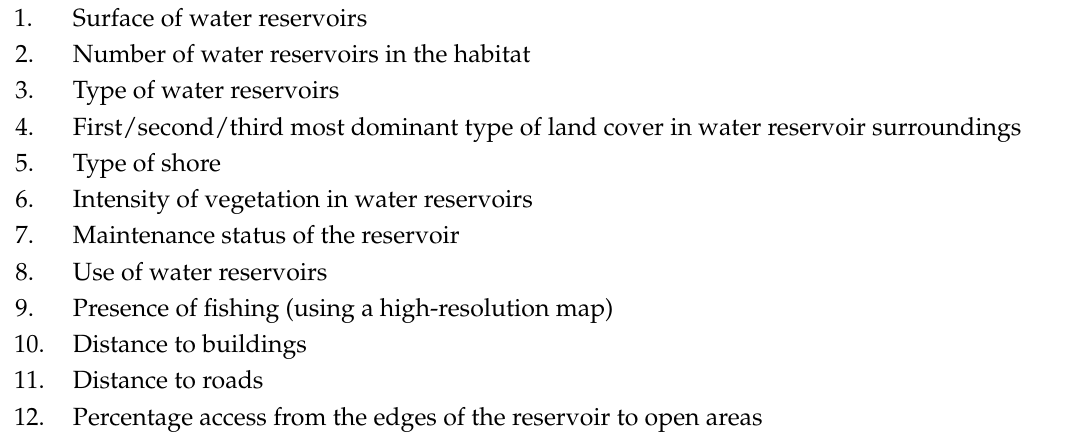
Table 1. Features and its properties used to assess amphibian habitats.